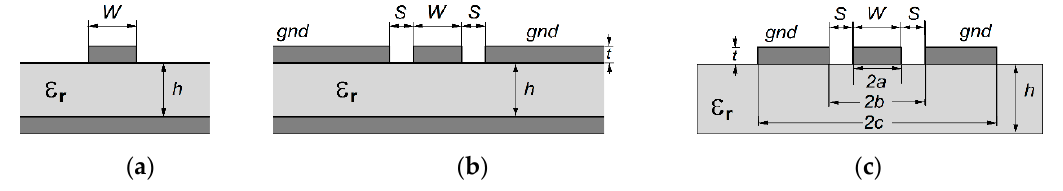
Figure 4. Microstrip ( a ), grounded coplanar waveguide ( b ), and coplanar waveguide ( c ) structures.